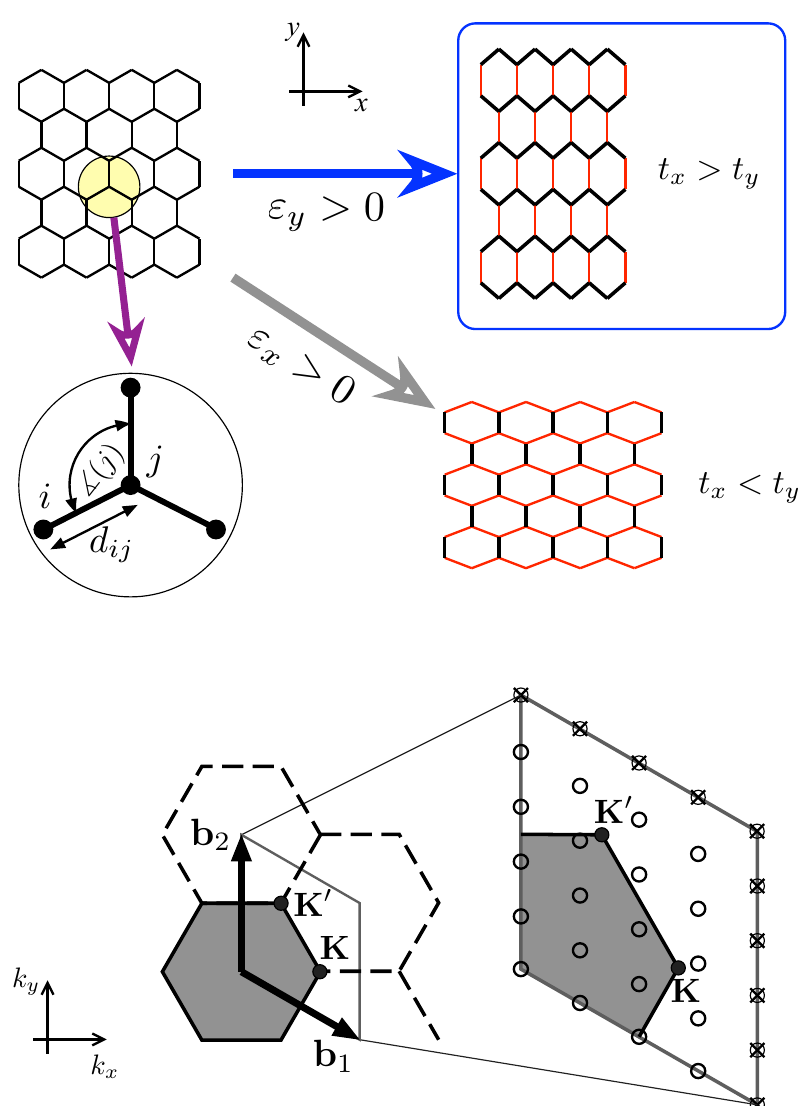
Figure 1. Top : Honeycomb lattice subjected to uniaxial strain in selected direction (see the coordinate system). Zoom-in visualizes the distance (bond length) d ij between atoms i and j and in-plane angle with the vertex at site j ( (cid:93) ( j ) ). Bottom : Hexagonal first Brillouin zone (FBZ) of the reciprocal lattice, with (dimensionless) basis vectors b 1 = symmetry points, K = ( 4 π /3,0 ) and K (cid:48) = ( 2 π /3,2 π / √ 3 ) coinciding with Dirac points in the absence of strain. The magnified area shows discretized FBZ for a finite system of N = 2 N x N y atoms with periodic boundary conditions [see Equation (6)]. (The values of N x = 4 and N y = 5 are used for illustration